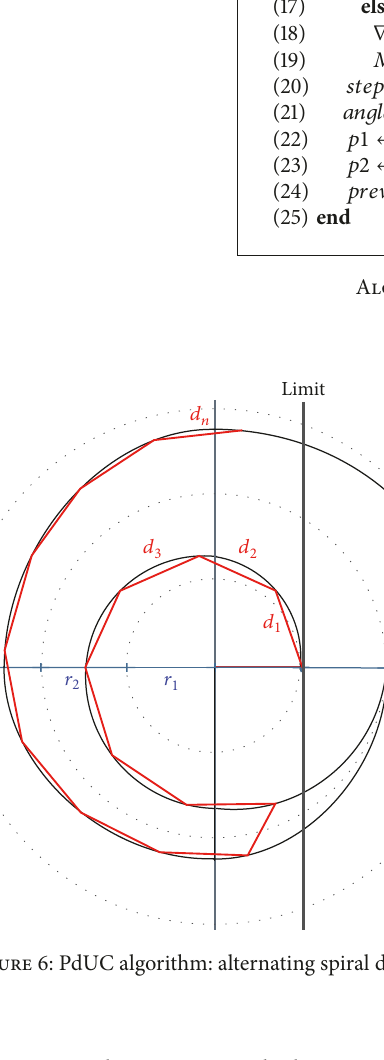
PdUC maintains a list containing the location of the central position of all spirals with their respective radius to determine the monitored areas (as a circumference determined by a center and a radius). Next, in the exploration phase, all points inside these circles are omitted for the sake of celerity, as shown in line 9 of Algorithm 2.